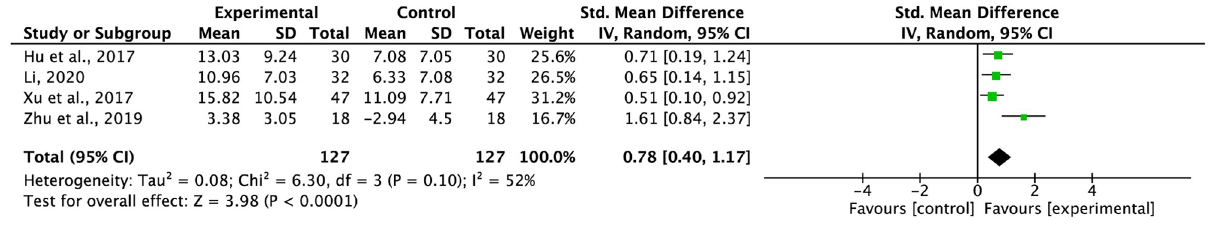
Fig 6. Meta-analysis results of QoL (continuous